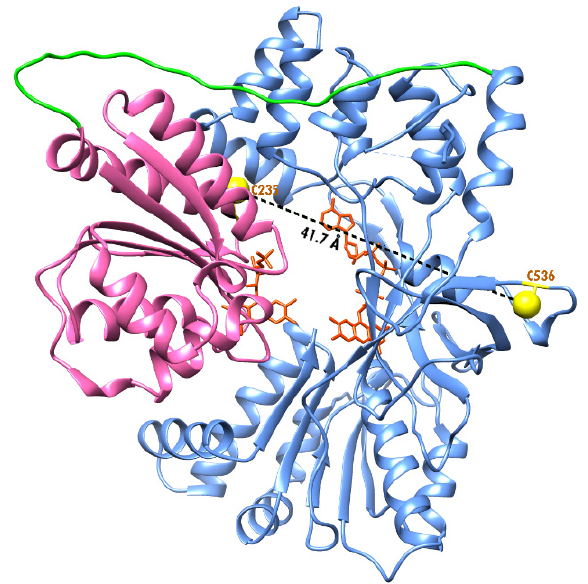
Figure 1. Structural model of SbCPR based on a combination of the resolved X-ray structure of the FAD domain (PDB ID: 7SUX) with the model of FMN domain and the connecting loop built with AlphaFold. The two modification-accessible cysteine residues are shown as yellow spheres. FMN and FAD domains are pink and light blue, respectively, and the connecting loop is green. FAD and FMN molecules are shown as orange stick models. The N-terminal transmembrane helix of the enzyme is not shown.